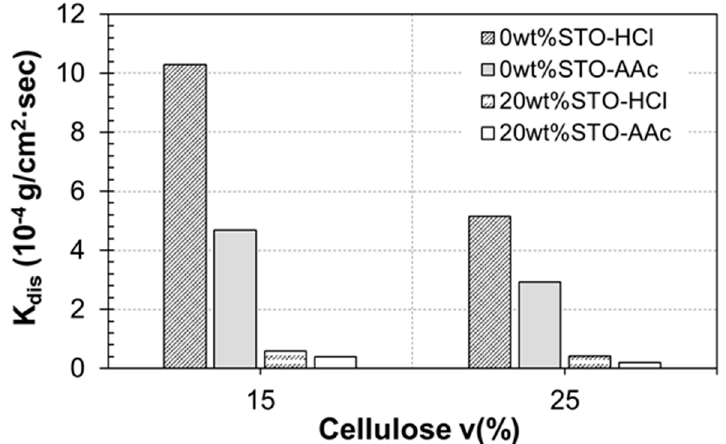
Figure 10. Dissolution rate constant k dis for bio-composites made of chitosan, cellulose, and STO nanoparticles.